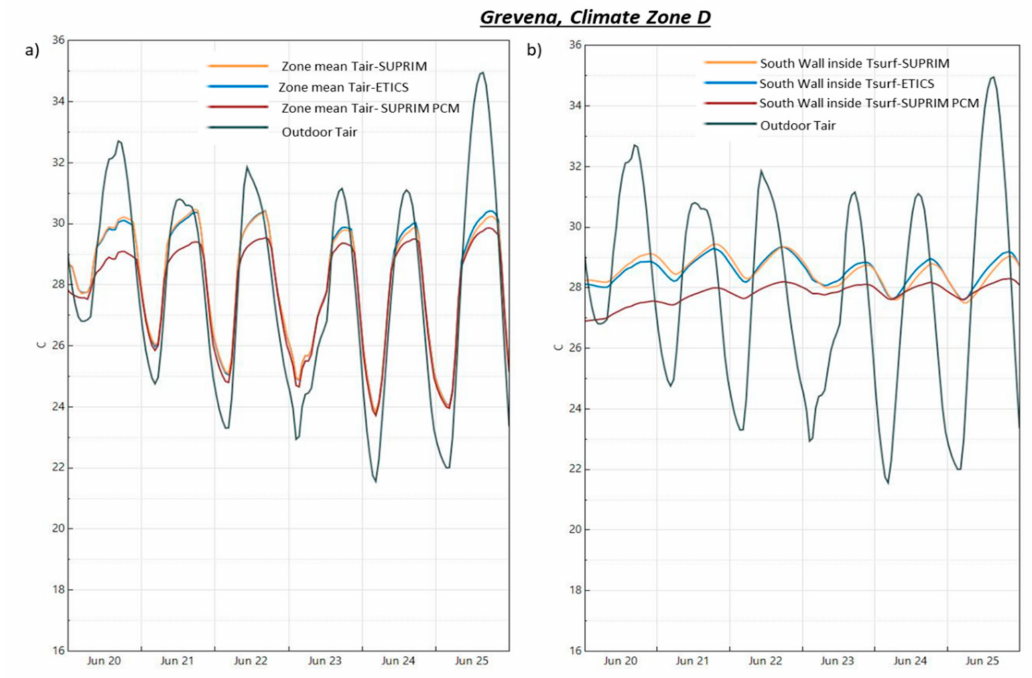
Figure 11. Climate zone D: ( a ) outdoor Tair and indoor Tair and ( b ) outdoor Tair and Tsurf evolution of the south facing wall during a typical week in June for the three investigated wall configurations and for 10 cm external